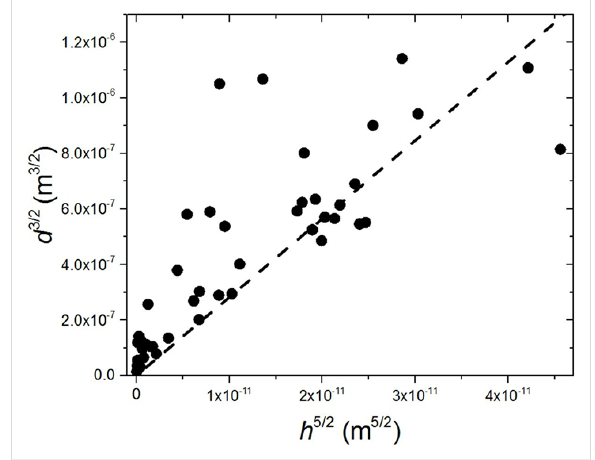
Figure 9: Graph of d 3/2 against h 5/2 , where d is the distance from the nearest area of close contact to the bead centre and h is the diameter of the bead (see Figure 6A). The slope of the line of best fit enables the Young’s Modulus of the pad to be estimated.